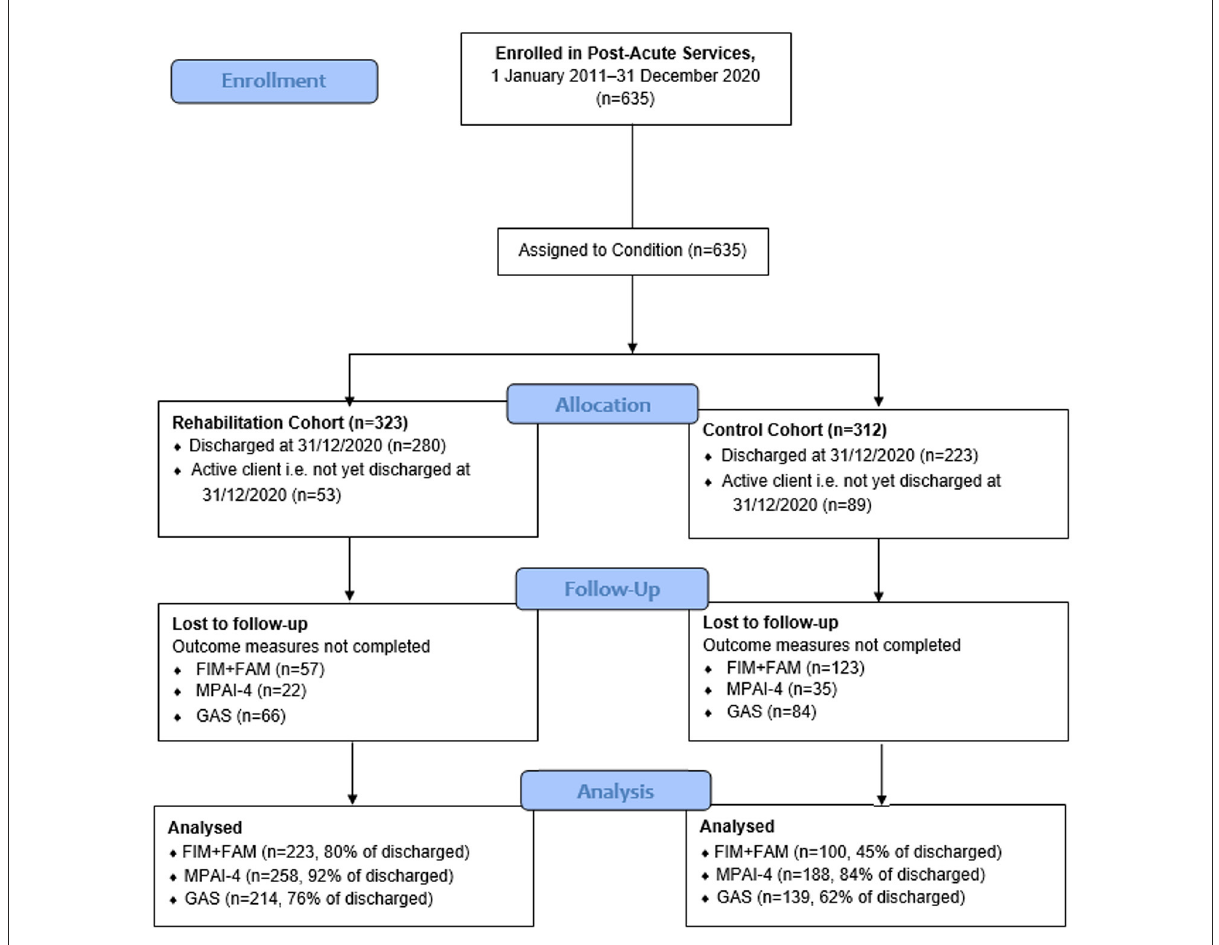
FIGURE2 Participant flow